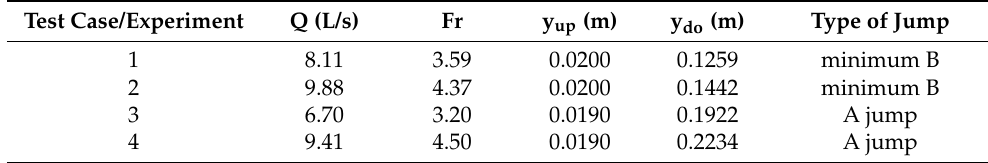
Table 2. Measured parameters for modeling of the hydraulic jumps.